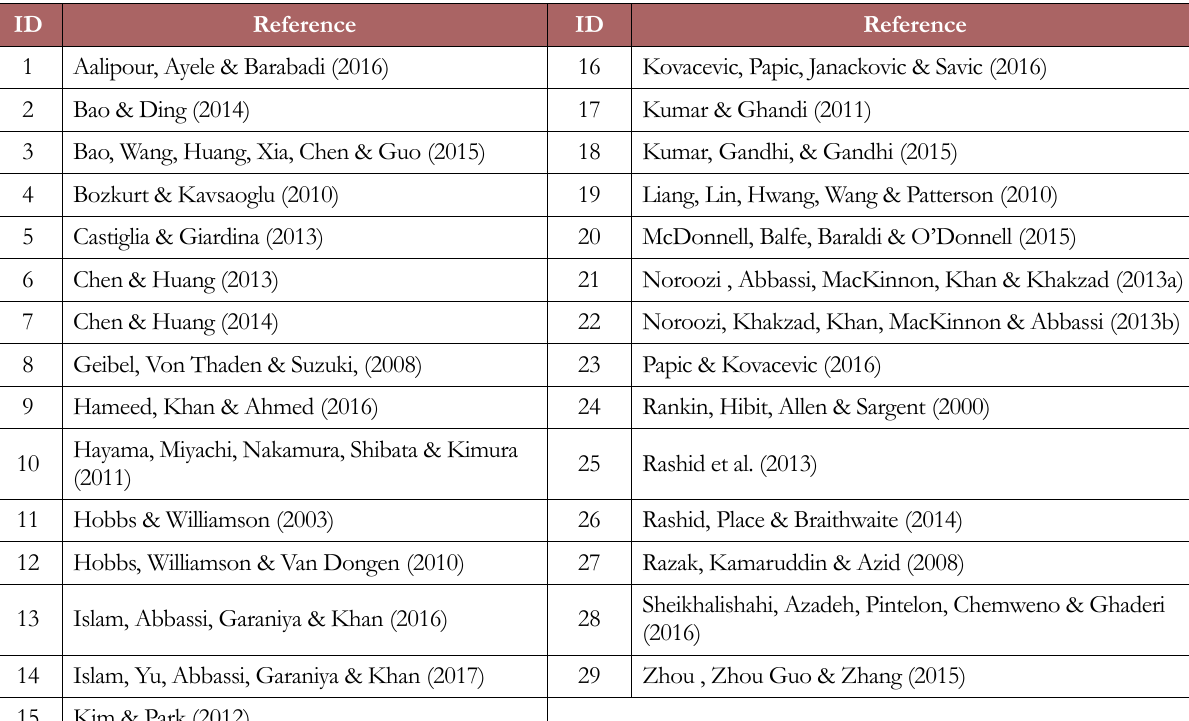
Table 2. List of the selected